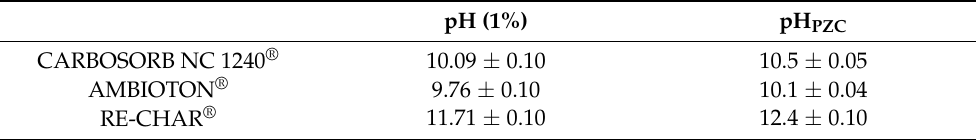
Table 8. pH and pH PZC (-) of CARBOSORB NC 1240 ® , AMBIOTON ® , and RE-CHAR ®